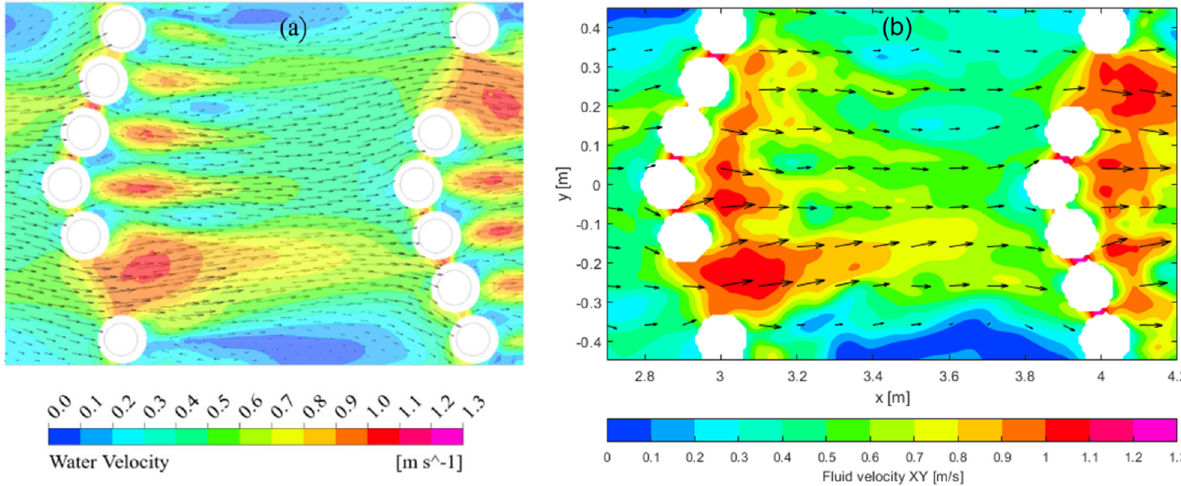
Figure 8. Velocity field at z = H /2 plane. ( a ) Results taken from the reference study [16] and ( b ) our model results.